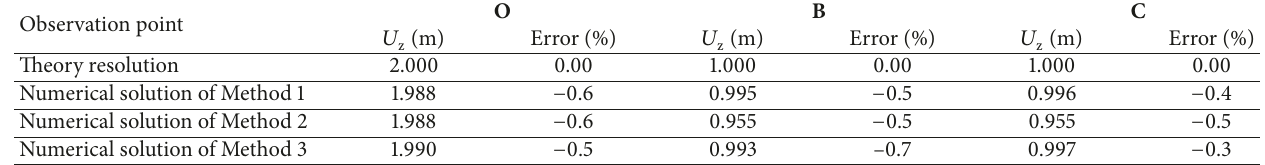
Table 4: Displacement maximums of different boundary methods and their relative errors in the Z direction.